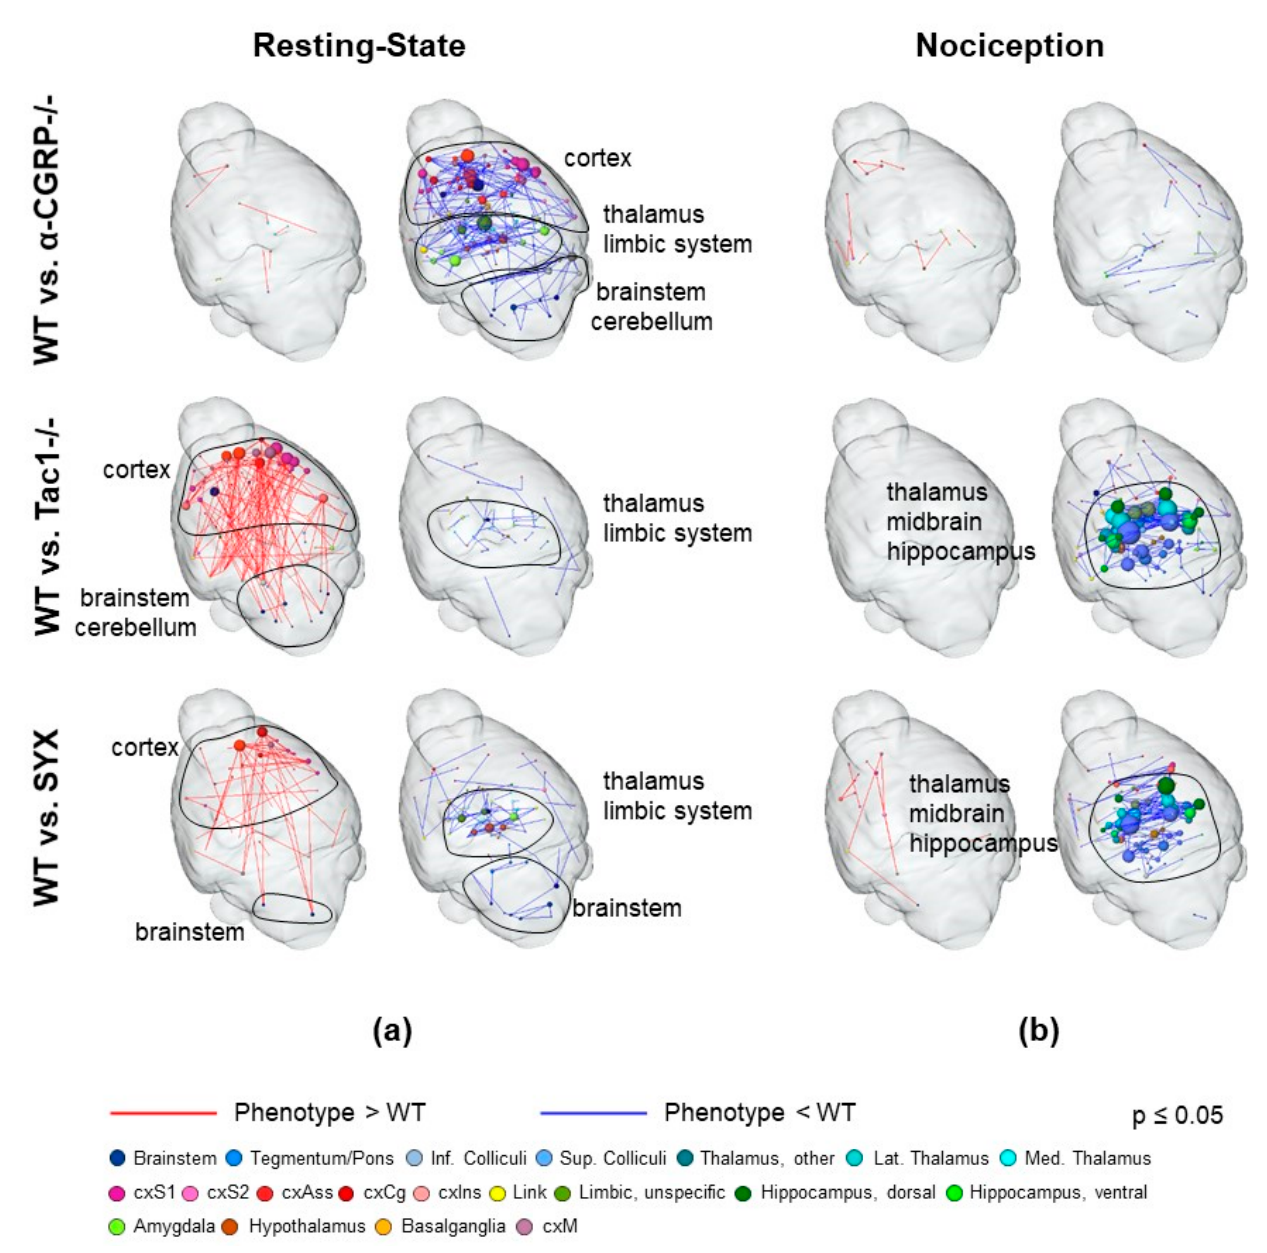
Figure 5. Baseline differences (day − 2) in resting-state (RS) and nociceptive functional connectivity (FC) between the three neurotransmitter-deficient mouse models compared to WT. Significant changes in RS ( a ) and nociceptive ( b ) functional connectivity between the three neurotransmitter-deficient (NT-deficient) mouse models used in this study in comparison to WT mice are displayed by red (connectivity is increased) or blue (connectivity is decreased) edges between color-coded nodes as brain regions. The size of the node represents the degree, i.e., how many connections this node has to others. Unconnected nodes are omitted. Abbreviations: cxS1 (primary somatosensory cortex), cxS2 (secondary somatosensory cortex), cxAss (association cortex), cxCg (cingulate cortex), cxIns (insular cortex), cxM (motor cortex), inf. (inferior), lat. (lateral), med. (medial), sup. (superior). (nWT = 13, nCGRP − / − = 9, nTac1 − / − = 9, nSYX =